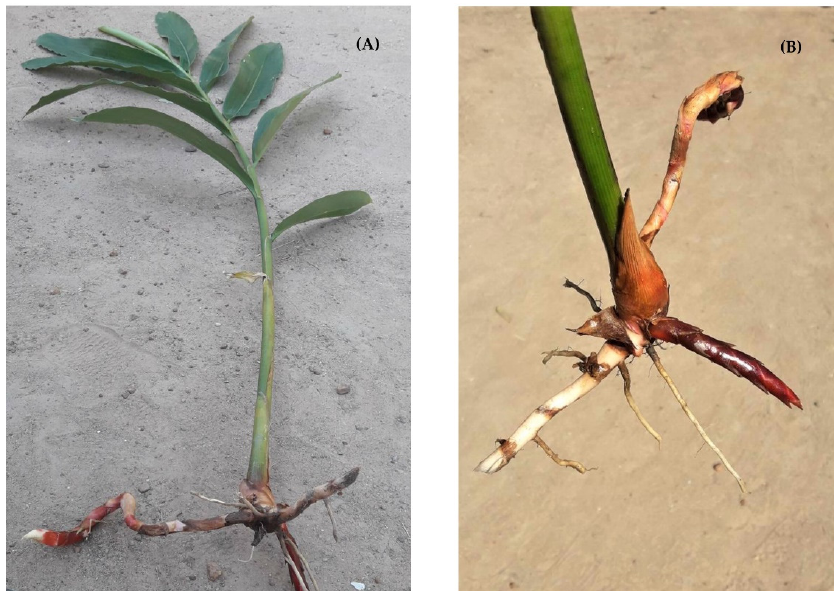
Figure 1. Photographs of Etlingera pavieana (Pierre ex Gagnep.) R.M.Sm. plant ( A ) and E. pavieana rhizome ( B ).